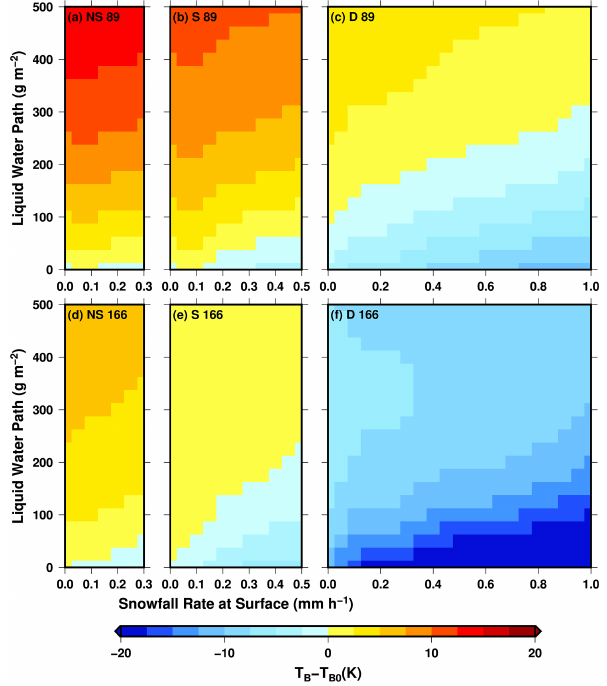
Figure 11. Simulated brightness temperature change (relative to clear-sky values) at GMI 89GHz (a, b, c) and 166GHz (d, e, f) for near-surface (a, d) , shallow (b, e) , and deep (c, f) snow clouds. The change is relative to clear-sky